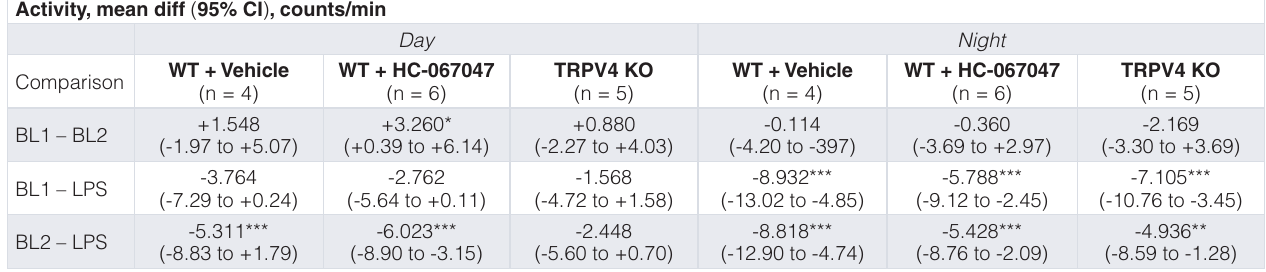
Dataset 2. Raw Data for Figure 3